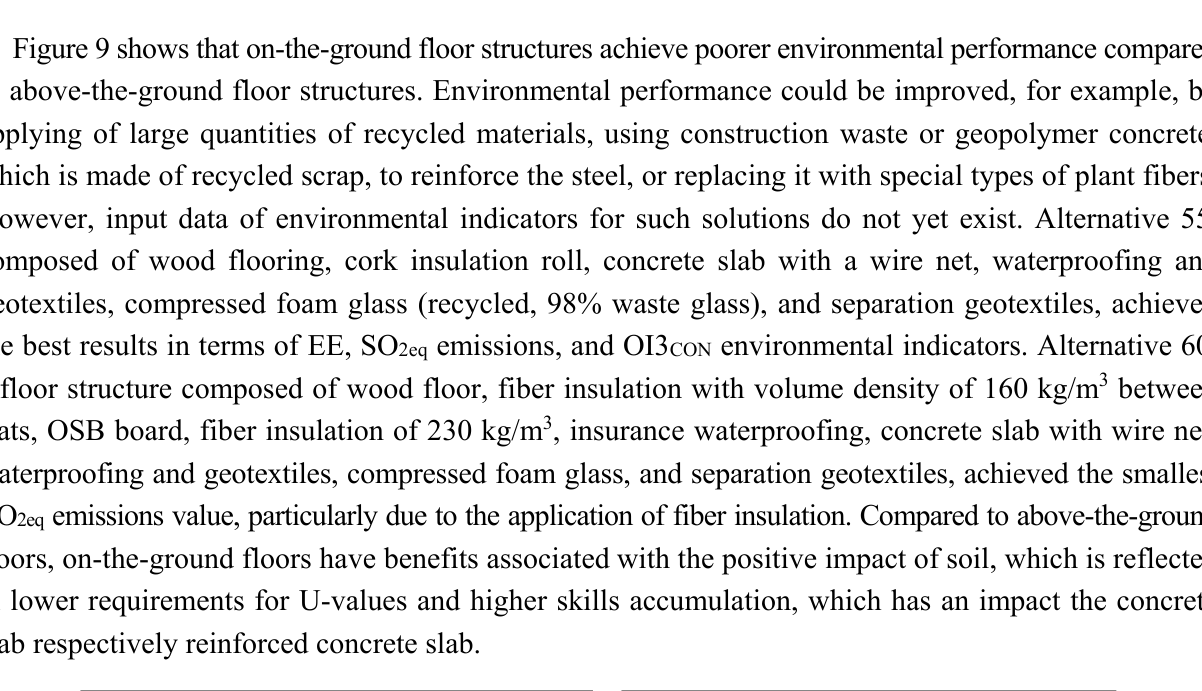
Figure 8. Mass per unit area and phase shift of thermal oscillation of on-the-ground floor